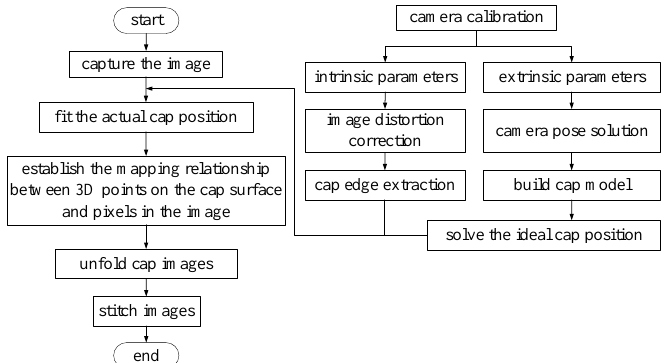
Figure 2. Algorithm flowchart. Figure 2. Algorithm